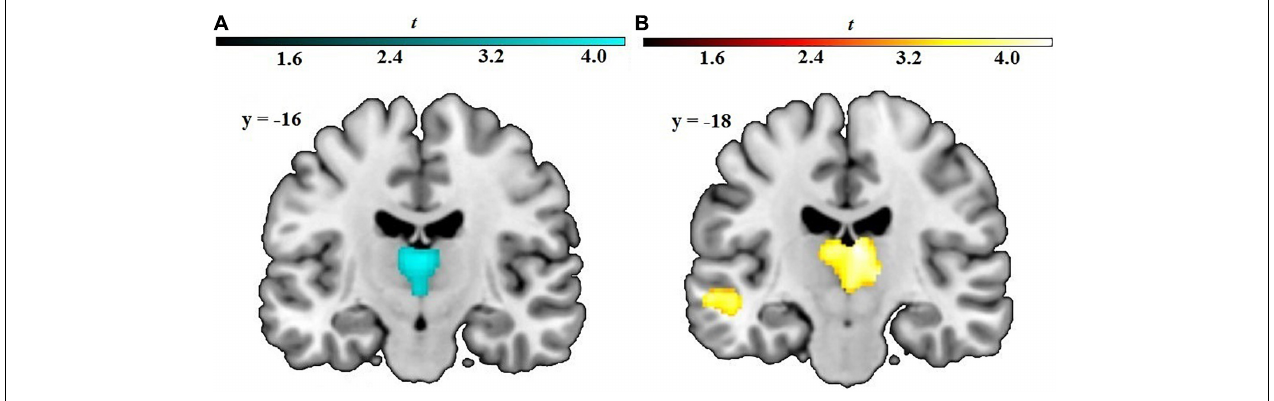
FIGURE 1 | Results from whole-brain regression analyses with (A) cognitive avoidance and (B) vigilance predicting GM volume. Axial images in neurological orientation showing the relation among (A) high cognitive avoidance and decreased GM volume in the bilateral thalamus, and among (B) high vigilance and volumetric increases in the bilateral thalamus and left middle temporal gyrus. The voxel-wise threshold was set to p = 0.001 (uncorrected) with a cluster-level threshold of p < 0.05, FWE-corrected. Color bar: t -values.